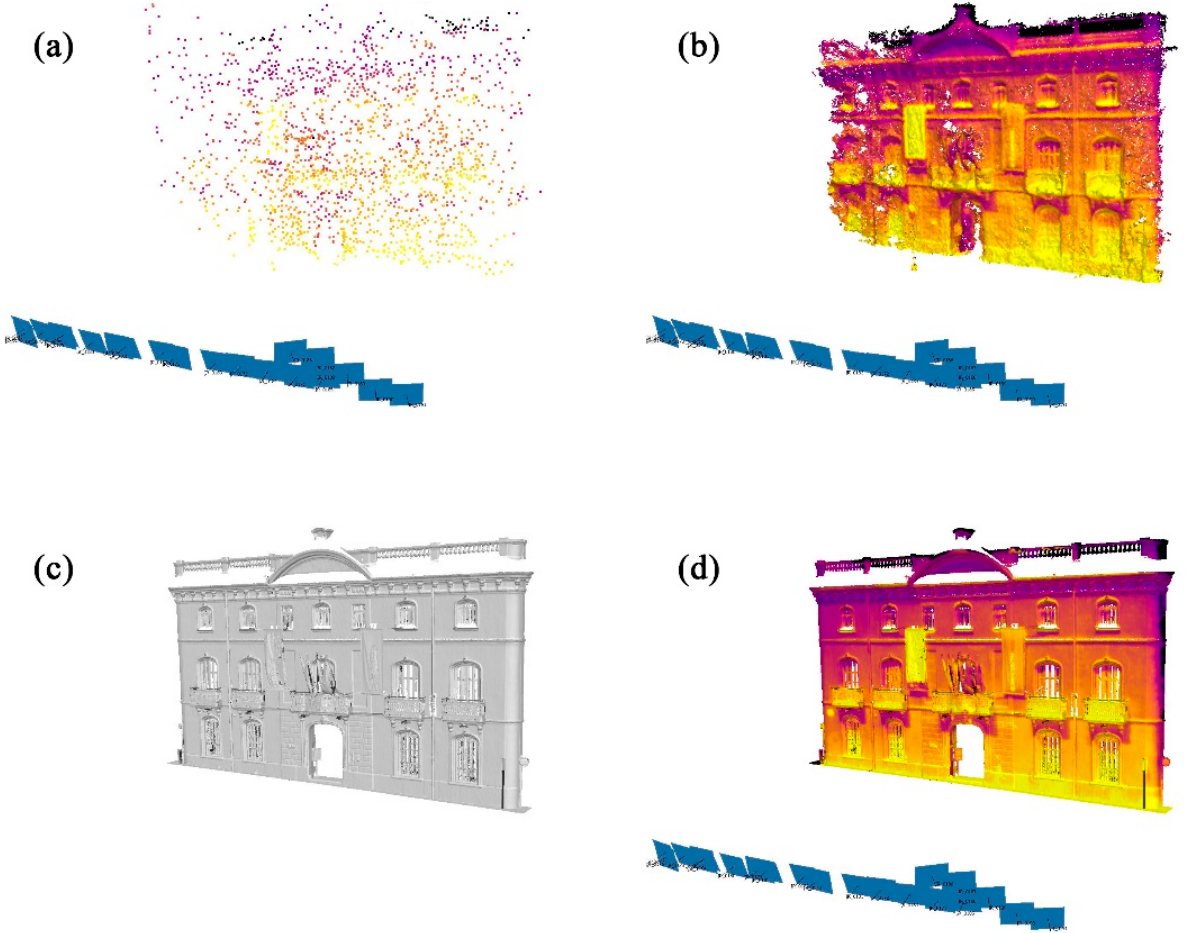
Figure 8. ( a ) Oriented thermal images and sparse cloud of tie points; ( b ) dense point cloud derived from thermal images, characterised by low resolution and topological errors; ( c ) high-resolution point cloud derived from LiDAR; ( d ) integration between the LiDAR point cloud (high-resolution geometry) and thermal data (information connected to the radiometry).